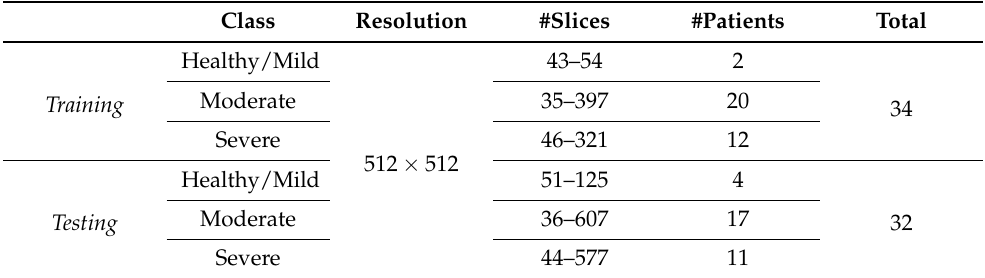
Table 1. Dataset